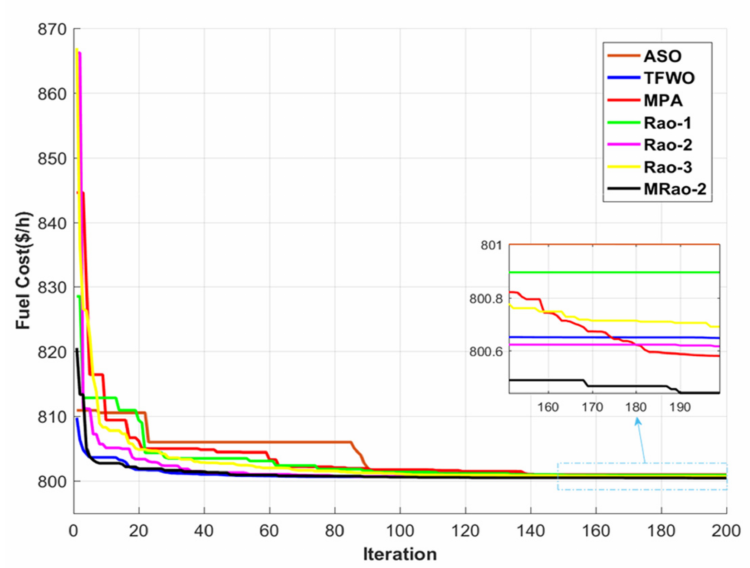
Figure 5. Convergence characteristics of the proposed MRao-2 and other recent algorithms for case 1.